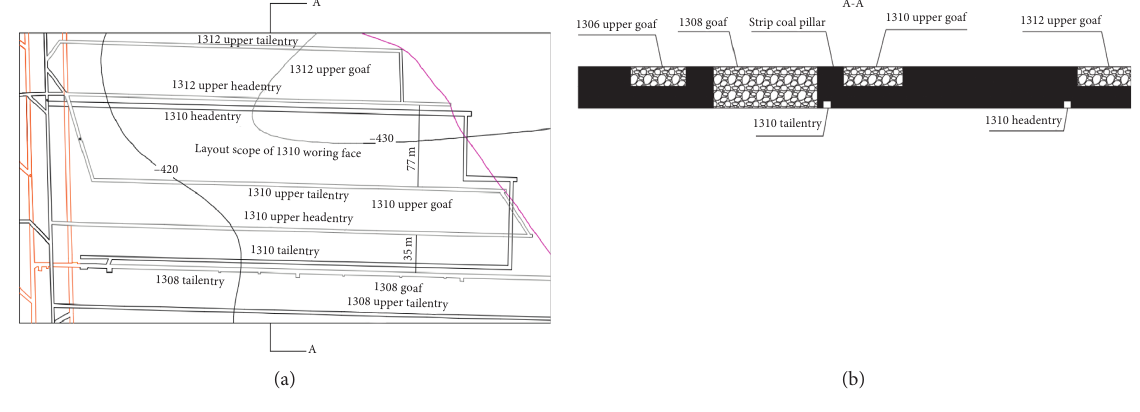
Figure 20: 1310 working face roadway layout plan.